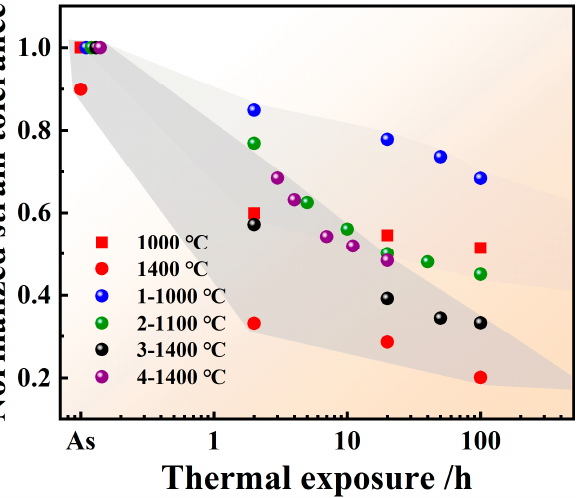
Figure 4. Changes in the ( a ) macroscopic and ( b ) microscopic elastic moduli of TBCs under thermal exposure.